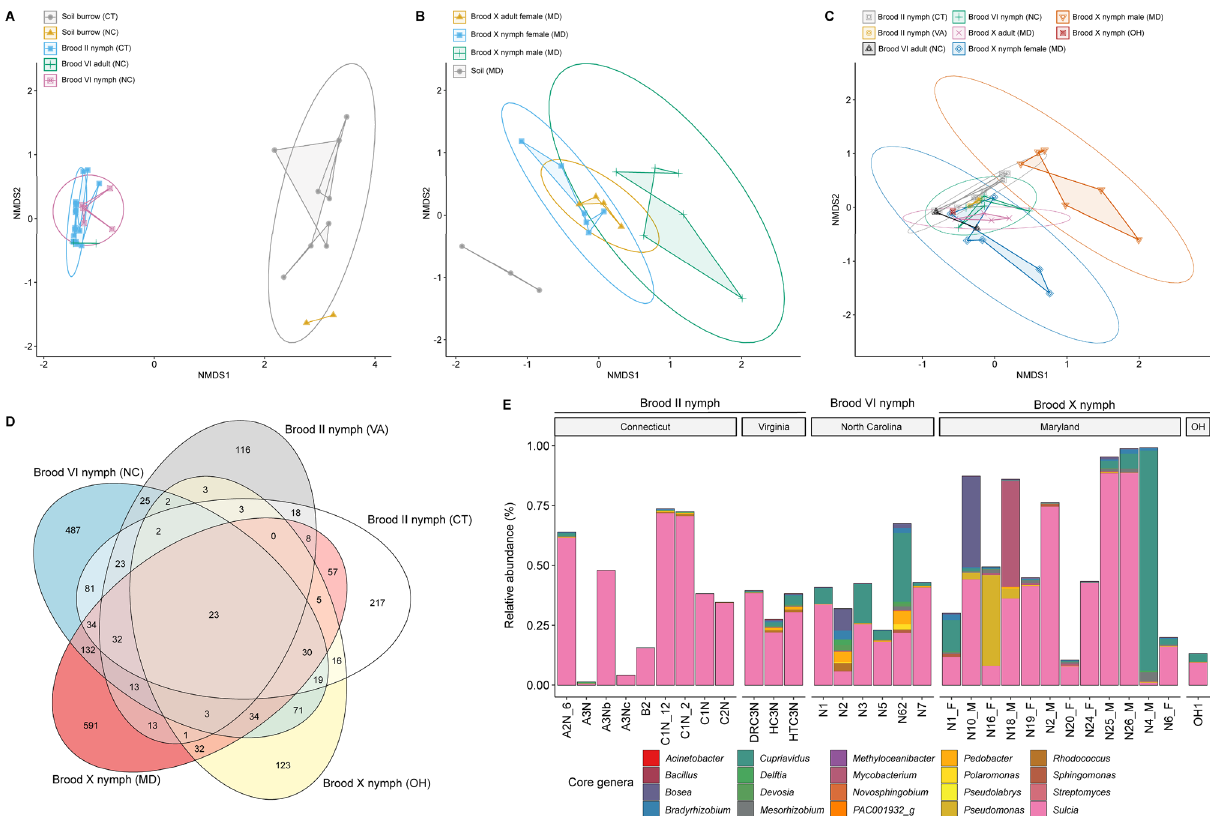
Figure 3. Beta diversity indices. NMDS plot of nymph gut microbiomes and microbiomes of ( A ) soil inhabited by nymphs in CT (Brood II) and NC (Brood VI), ( B ) Brood X gut microbiomes and microbiomes of soil in MD, and ( C ) cicada gut microbiomes showing life stage, brood, collection location, and sex of Brood X cicadas. Ellipses represents 95% confidence interval based on Bray–Curtis dissimilarity index. ( D ) Venn diagram of bacterial communities showing the number of shared and exclusive bacterial taxa is shown relative to MTP set. ( E ) Relative abundance of 20 most common core bacterial genera detected across all MTP